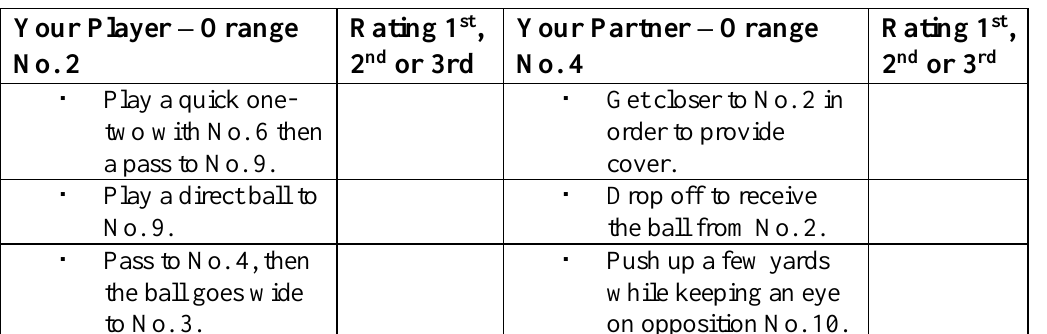
Figure 5.2 Tactical Sheet without a Correct Answer Available for both